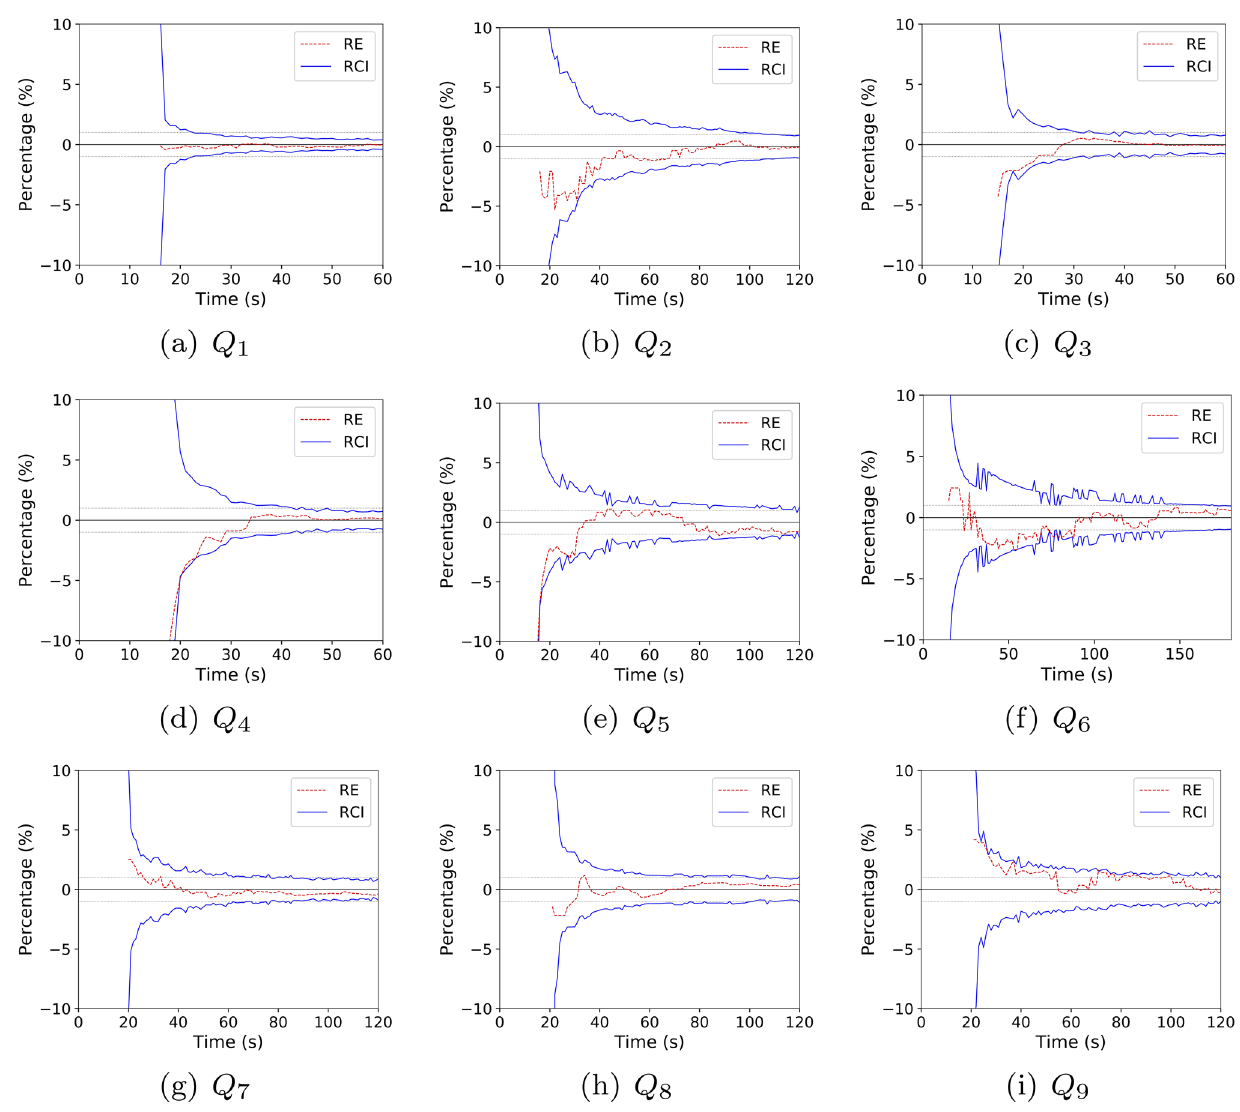
Fig. 4 The convergence of RE and RCI for Q 1 – Q